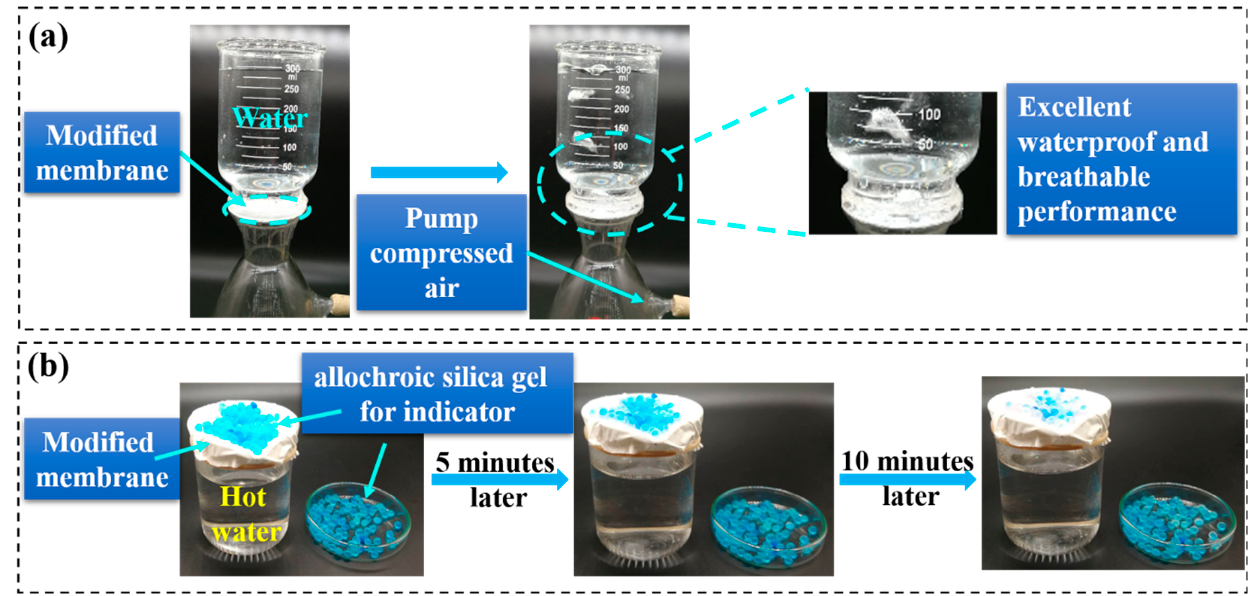
Figure 11. The waterproof and breathable performance of the SBS/PDA/SiO 2 fibrous membrane. ( a ) Waterproof and breathable performance and ( b ) moisture